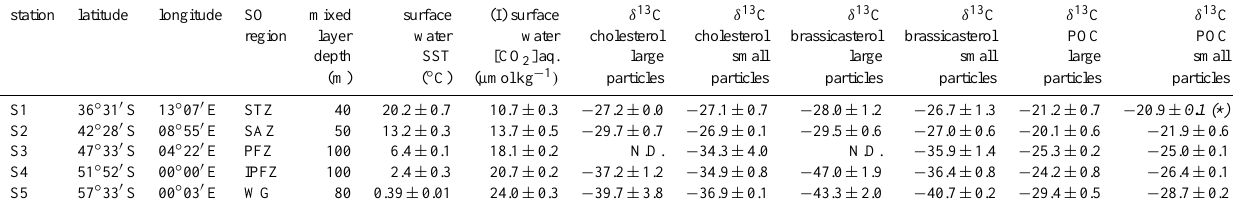
Table 1. Mixed layer depth MLD (m), sea surface temperature (SST), surface CO 2 aq. concentration (µmolkg − 1 ) , surface δ 13 C (‰) for LP and SP-POC, LP and SP-cholesterol, LP and SP-brassicasterol. Standard deviation ( ± 1 σ) is the average standard deviation with one exception: (*)=analytical standard error ( ± 1 σ) . STZ=Sub-Tropical Zone, SAZ=Sub-Antarctic Zone, PFZ=Polar Frontal Zone, IPFZ=Intermediate Polar Frontal Zone (also named Southern Antarctic Circumpolar Current Front or SACCF), and WG=Weddell Gyre.